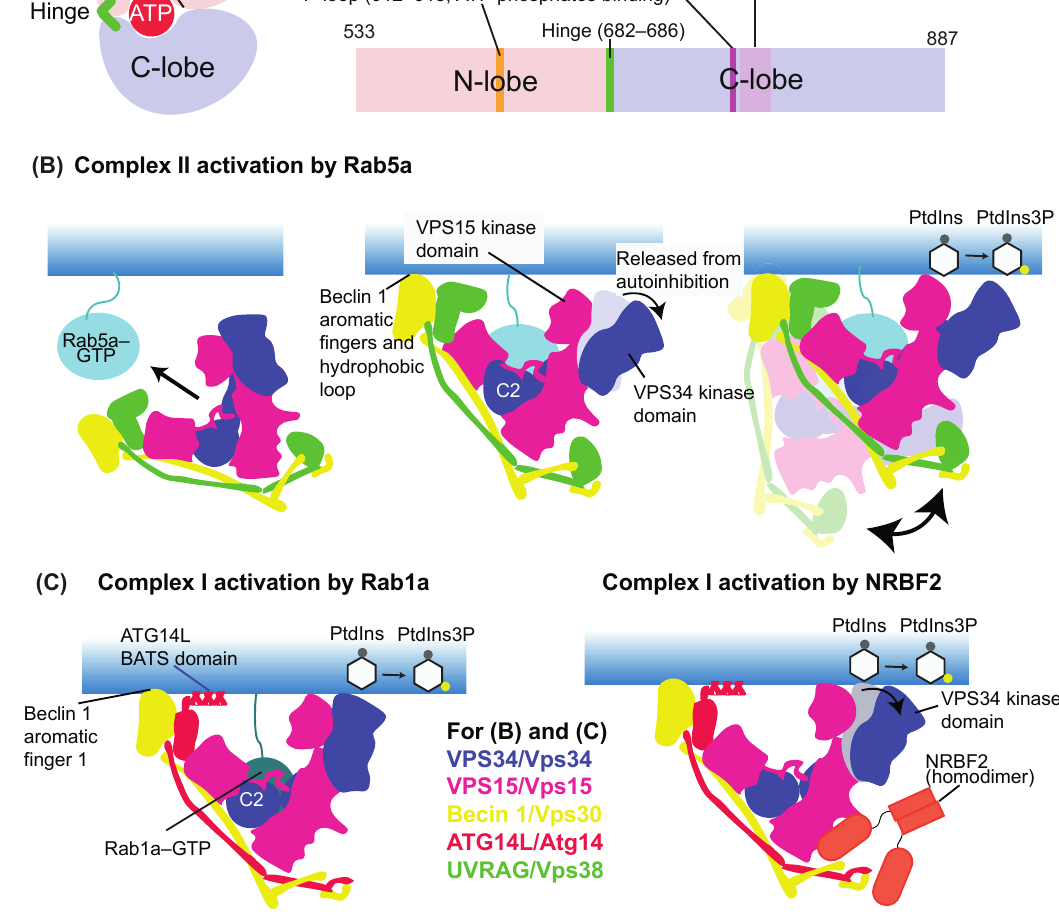
Figure 3. Activation mechanisms of VPS34/Vps34 complexes. ( A ) Schematic representations of the VPS34/Vp34 kinase domain. Left: A simplified structure of the kinase domain. An ATP molecule is sandwiched by the N- and C-lobes, which are connected by the hinge region. Right: A schematic representation of the kinase domain in human VPS34, modified from [35] . Residue numbering shown is for the human VPS34. ( B ) The activation mechanism of human complex II by Rab5a. Left: Complex II is recruited in an autoinhibition form to early endosomes by the early endosome specific small GTPase Rab5a in a GTP-dependent manner. Middle: The Rab5a binding not only recruits complex II to the membrane but releases the VPS34 kinase domain from autoinhibition by the VPS15 kinase domain. Rab5a binds mainly to the C2 helical hairpin insertion (C2HH) of VPS34, along with the small globular domain (SGD) and WD40 domain in VPS15. Along with Rab5a, three motifs in the Beclin 1 BARA domain are responsible for the membrane binding. Right: The membrane-an- chored active complex II can tilt up and down to phosphorylate PtdIns and synthesize PtdIns(3)P. ( C ) Activation mecha- nisms of complex I. In addition to the Beclin 1 aromatic finger 1, the ATG14L BATS domain is essential for the membrane anchoring of complex I. Left: Complex I activation by Rab1a. GTP-bound Rab1a binds to the same C2HH in VPS34 as Rab5a–complex II, but not to the VPS15 SGD or WD40. Right: Complex I activation by the complex I-specific binding protein NRBF2.